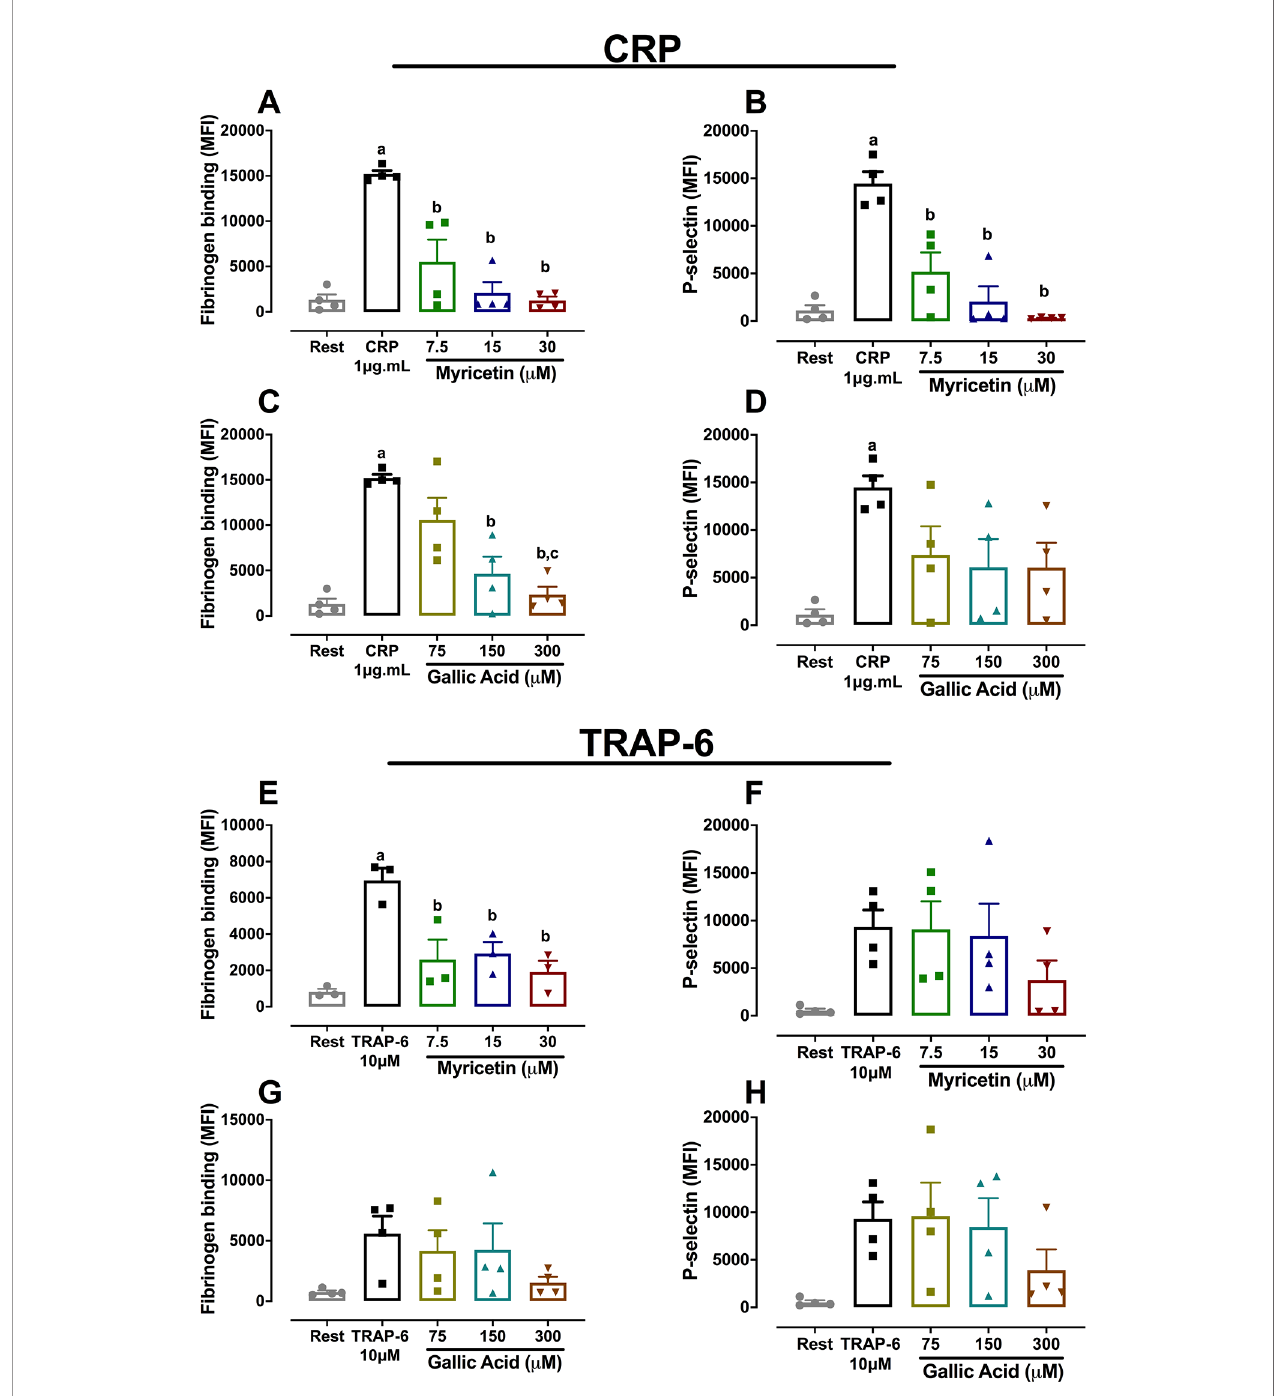
FIGURE 3 | Platelet activation and alpha-granule secretion is inhibited by myricetin but not by gallic acid. Washed platelets (WP) were pre-treated with myricetin or GA for 10 min, stimulated with agonists, and incubated with FITC-coupled fi brinogen and PE/PerCP anti-P-selectin antibodies. Fibrinogen binding (A) and P-selectin exposure (B) of CRP-activated platelets treated with myricetin. Fibrinogen binding (C) or Pselectin exposure (D) of CRP-activated platelets treated with GA. Fibrinogen binding (E) and P-selectin exposure (F) of TRAP-6-activated platelets treated with myricetin. Fibrinogen binding (G) and P-selectin exposure (H) of TRAP- 6-activated platelets treated with GA. a p < 0.05 vs fi rst column of graph. b p < 0.05 vs second column of graph. c p < 0.05 vs third column of graph. Data analyzed by paired one-way ANOVA and Tukey as post-test. All bar graphs represent mean ± SEM as well as individual data points of at least three independent